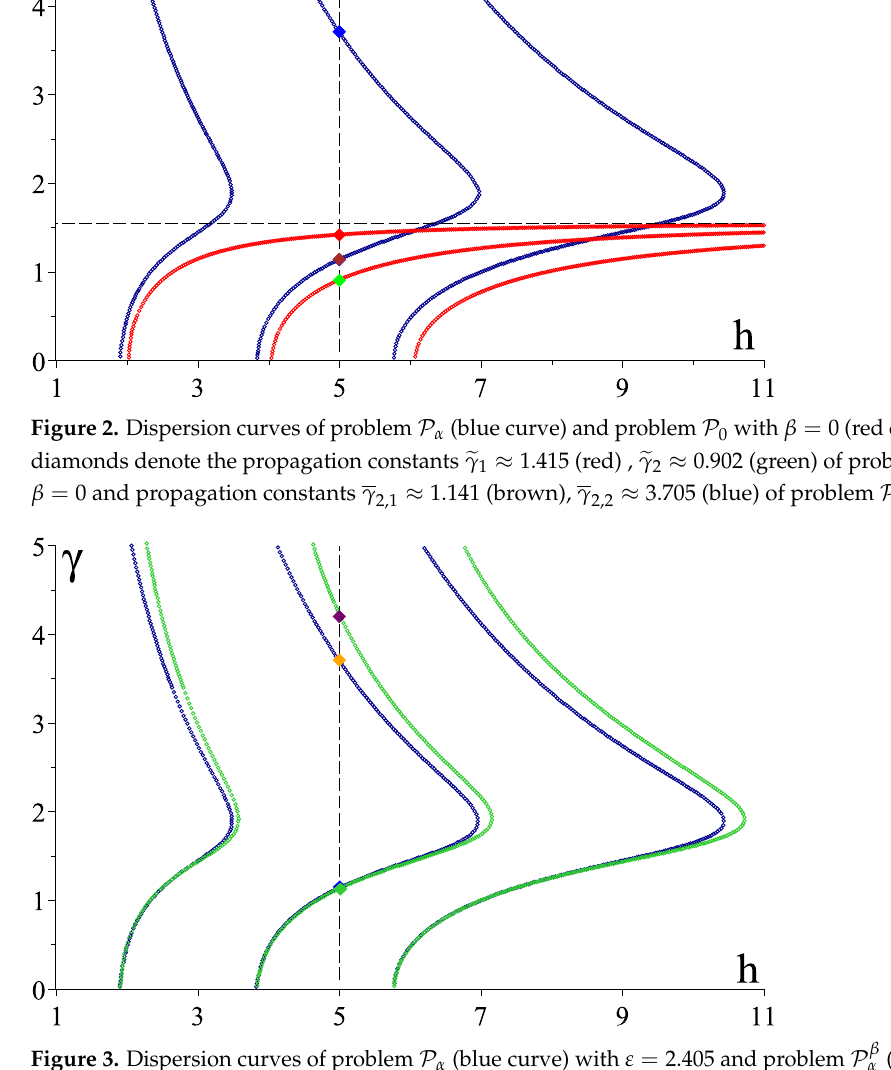
Figure 3. Dispersion curves of problem (blue curve) with ε = 2.405 and problem P α with ε = 2.405 + 0.05cos ( x ) . Solid diamonds denote the propagation constants γ 2,1 γ 2,2 3.705 (orange) of problem and propagation constants (cid:98) γ 2,1 ≈ P α β (purple) of problem α P